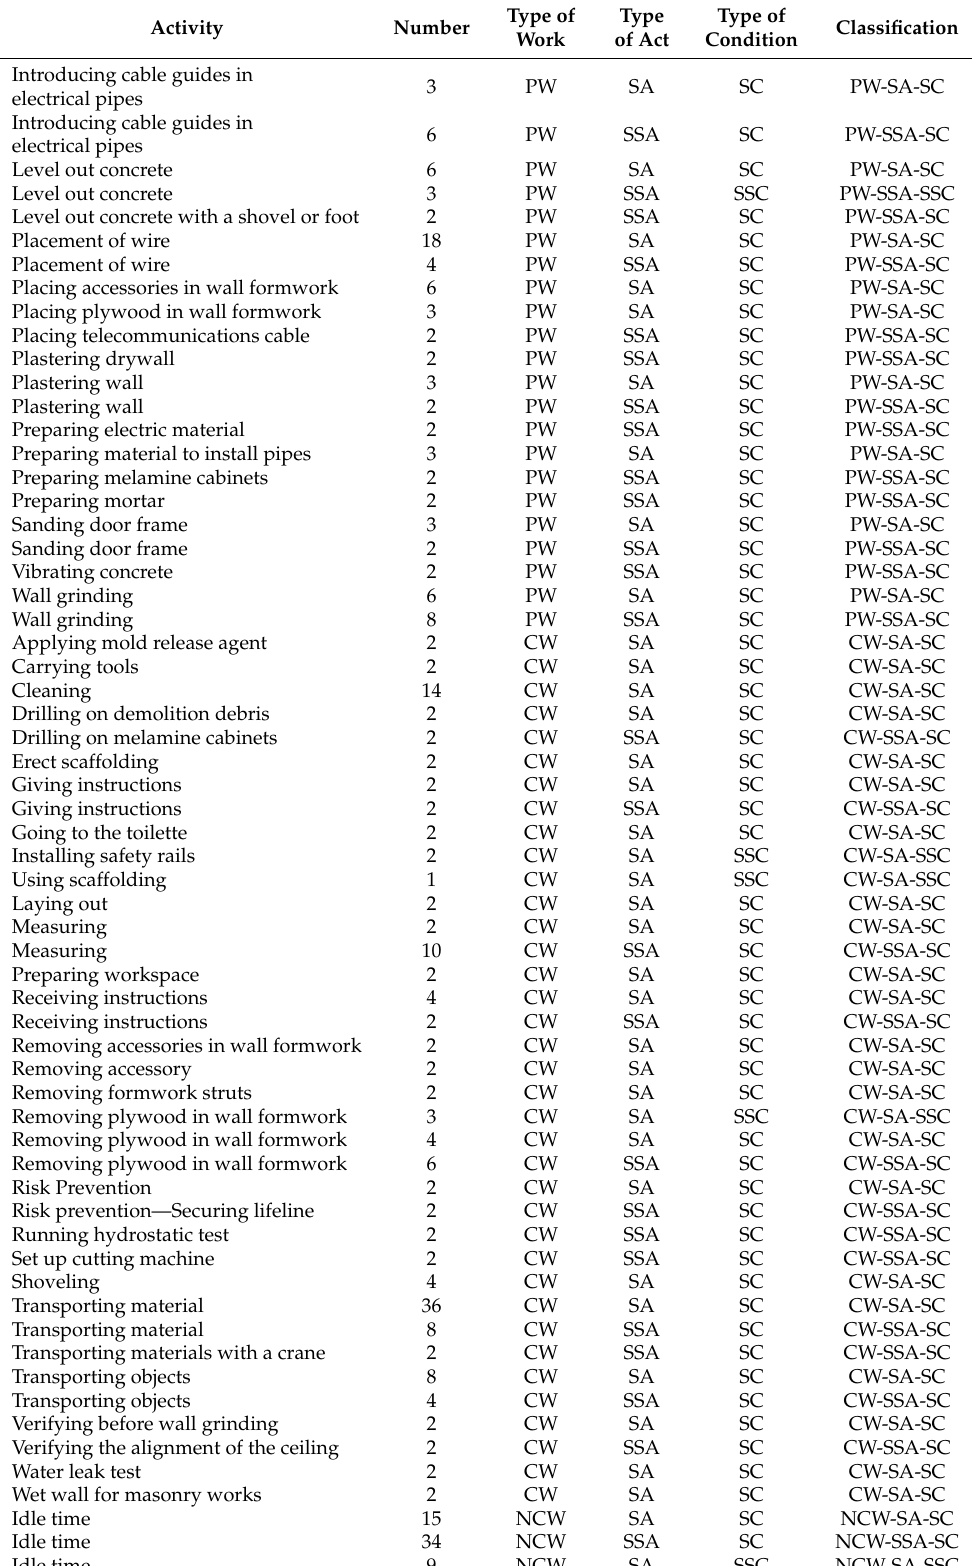
Table 5. Cont. Activity Introducing cable guides in electrical